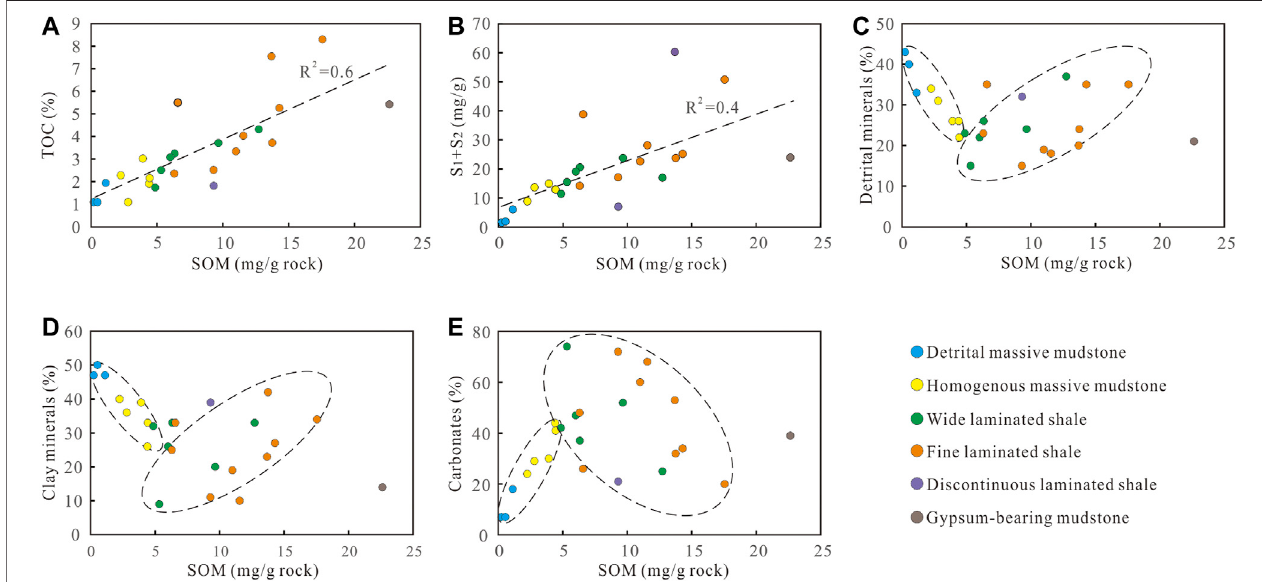
FIGURE 9 | OM-SOM and mineral-SOM relationship in shale with different lithofacies.